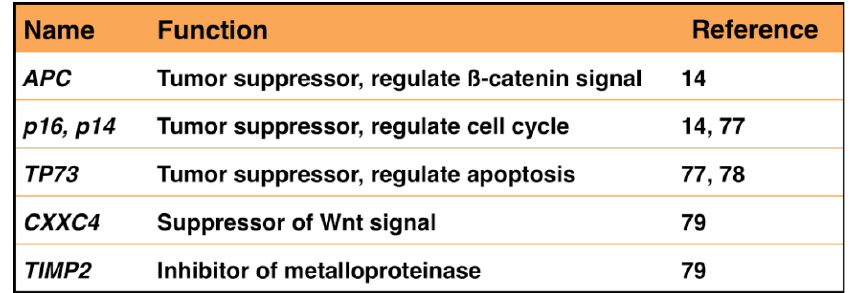
Table 1. DNA hypermethylation in